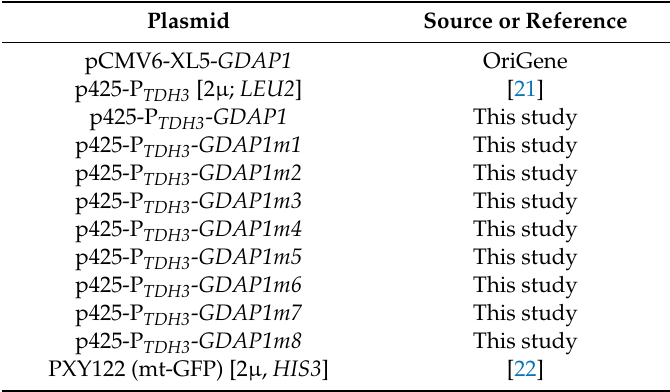
Table 1. Plasmid used in this study. Plasmid Source or